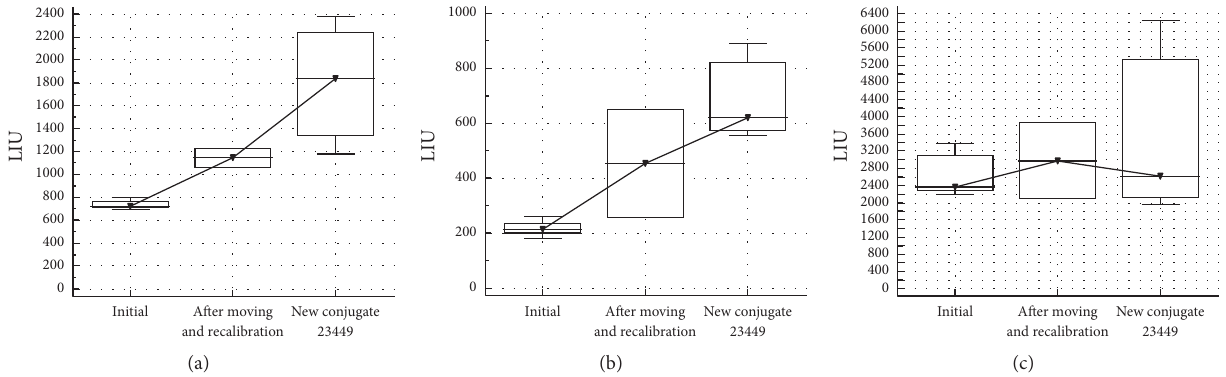
Figure 3: Results of LIU initial interrun variability, interrun variability after relocation and subsequent calibration, and interrun variability after changing to another conjugate lot number for laboratory 7 for samples 1, 2, and 3 ((a), (b), and (c),